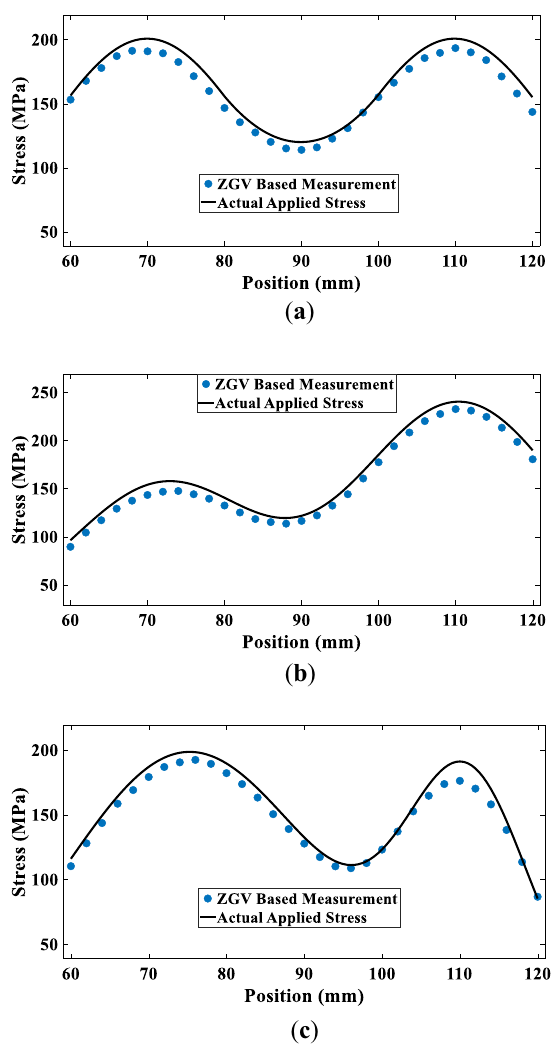
Figure 12 Measurement results for multiple localized stress fields: ( a ) Two localized stresses with identical feature, ( b ) Two localized stress with different stress peak, ( c ) Two localized stress with different stress